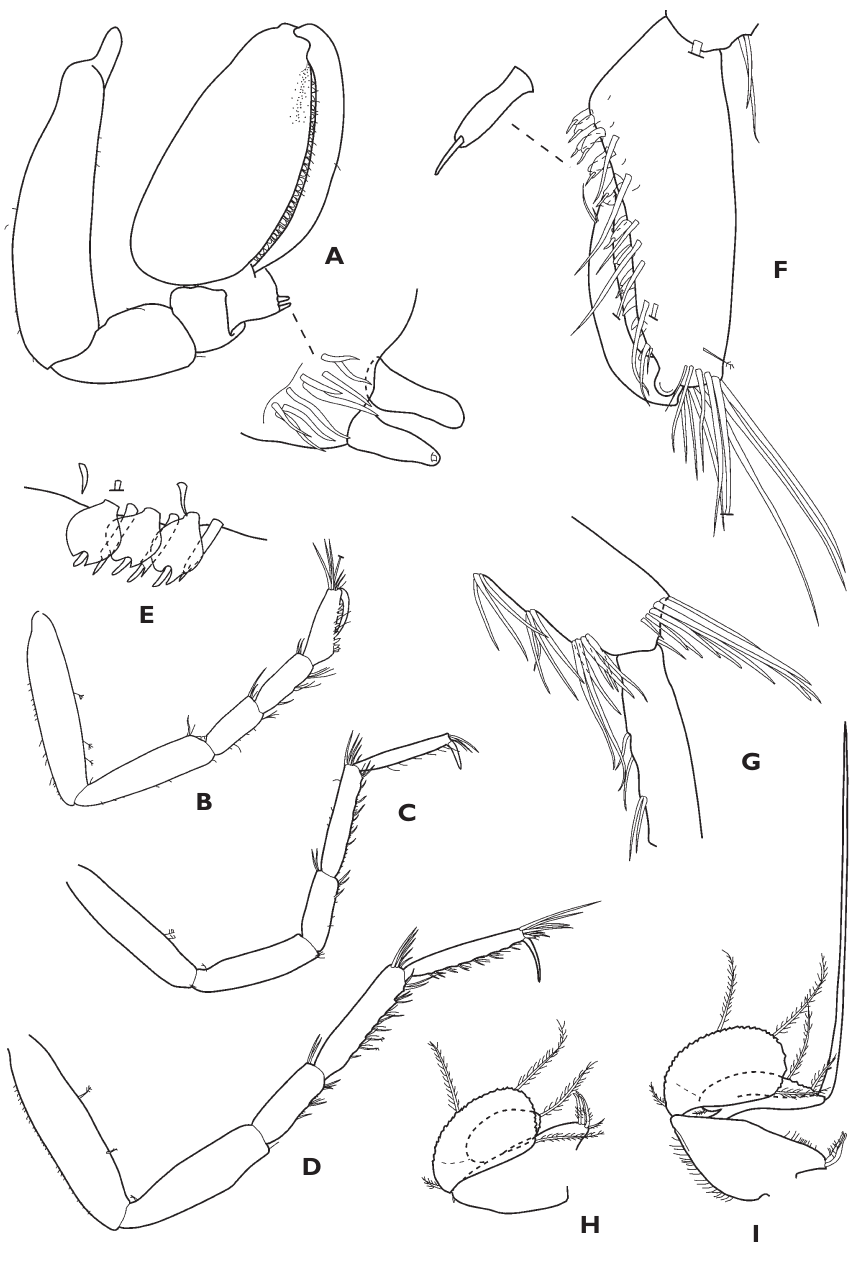
Figure 14. Myopiarolis lippa sp. n. Holotype. A–D pereopods 1, 2, 6 and 7 respectively E detail of propodal palm setae F pereopod 2 propodus G pereopod 6 distal articles H pleopod 1 I pleopod